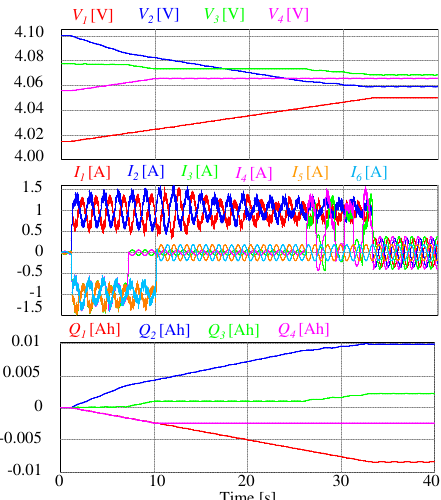
Figure 27. Equalization of a four-cell battery bank using the ´Cuk converter